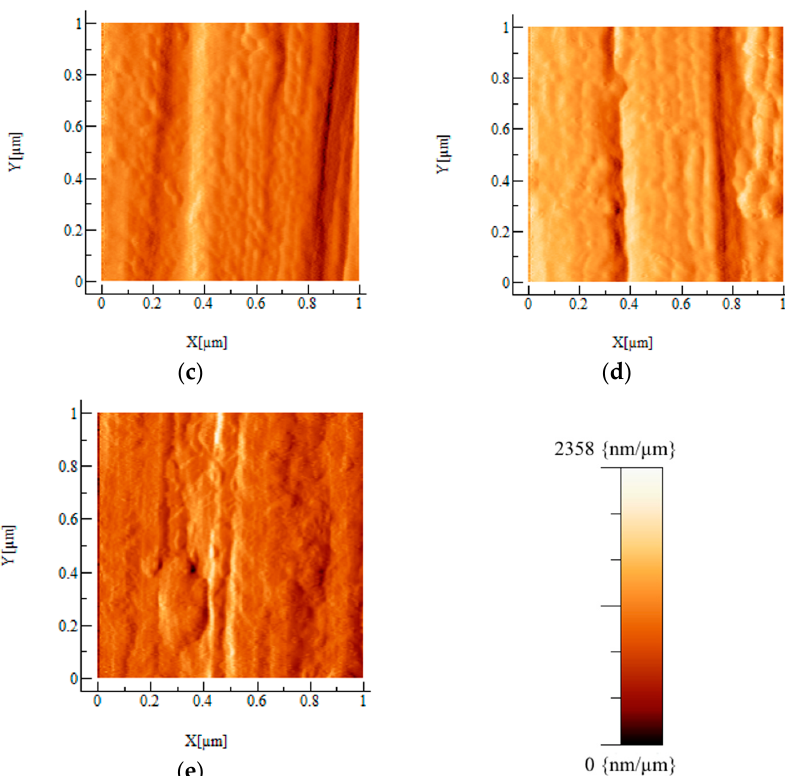
Figure 4. AFM images of uncoated and coated carbon fibers in 2D derivative mode: carbon fibers without coating ( a ); and carbon fibers modified with coating 1 ( b ); coating 2 ( c ); coating 3 ( d ); and coating 4 ( e ).